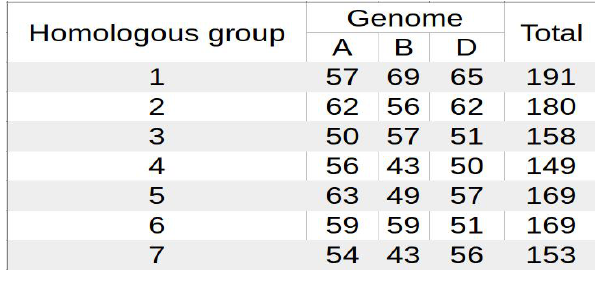
Table 3. Distribution of unigenes containing SSR across the chromosomes, the three subgenomes, and the seven homologous of bread wheat.